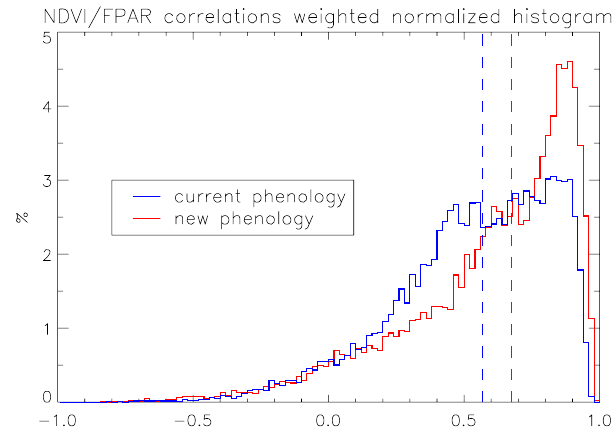
Fig. 3. NDVI/FPAR monthly correlations weighted histograms for the current phenology (blue curve) and for the new phenology (red curve) simulations, both forced by ERA-I fields (binsize = 0.02). The vertical dashed lines indicate the weighted median